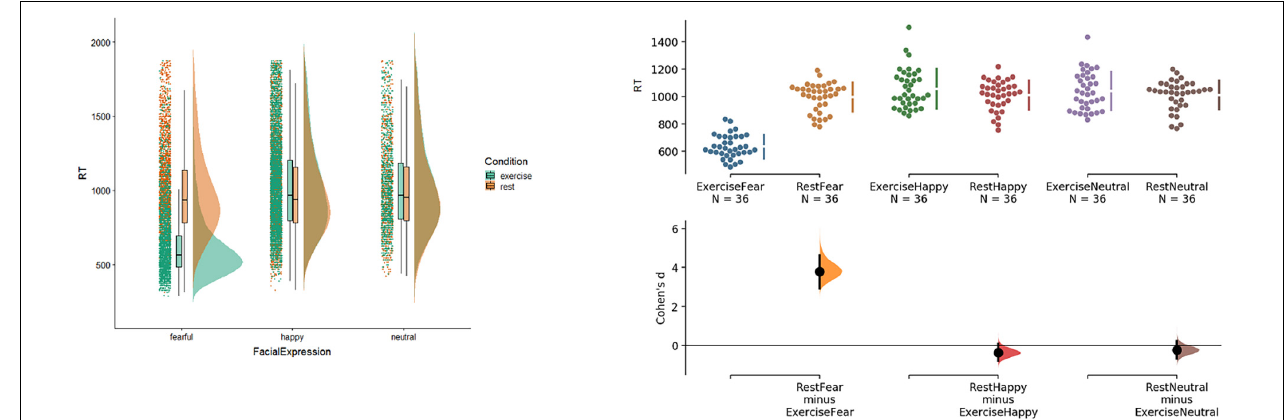
FIGURE 1 | Response times for Condition and Facial Expression. Left: raincloud plots on correct response time. The plots visualize jittered raw data-points, box plots with median and extreme values, and probability distributions of correct response time for Condition and Facial Expression. Right: Cumming estimation plots and Cohen’s d on the same data. Raw data (response time in milliseconds) are plotted on the upper axes. Each mean difference is plotted on the lower axes as a bootstrap sampling distribution. Mean differences are depicted as dots; 95% confidence intervals are indicated by the ends of the vertical error bars. See the main text for